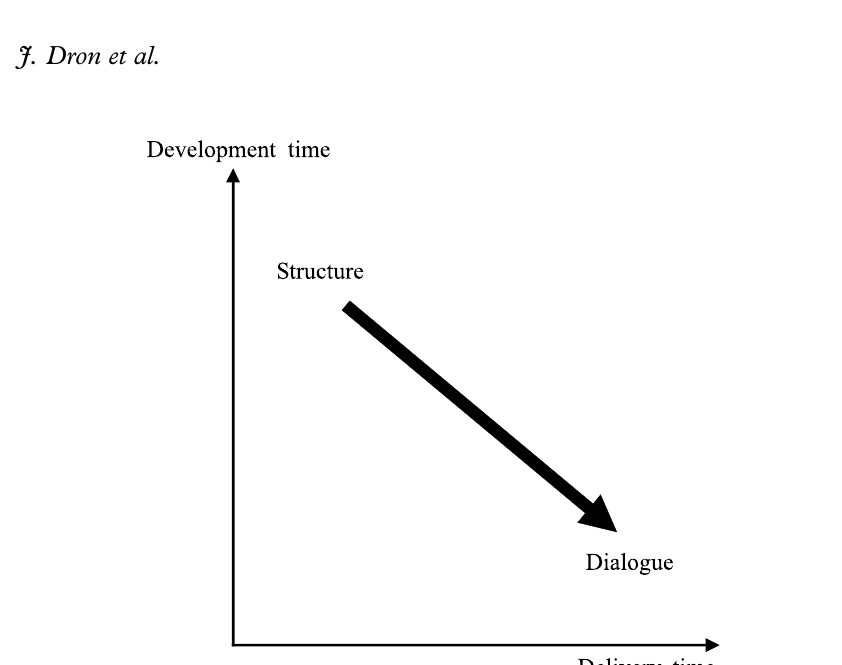
Figure 2. Relationship of delivery to development time for structured/dialogic delivery